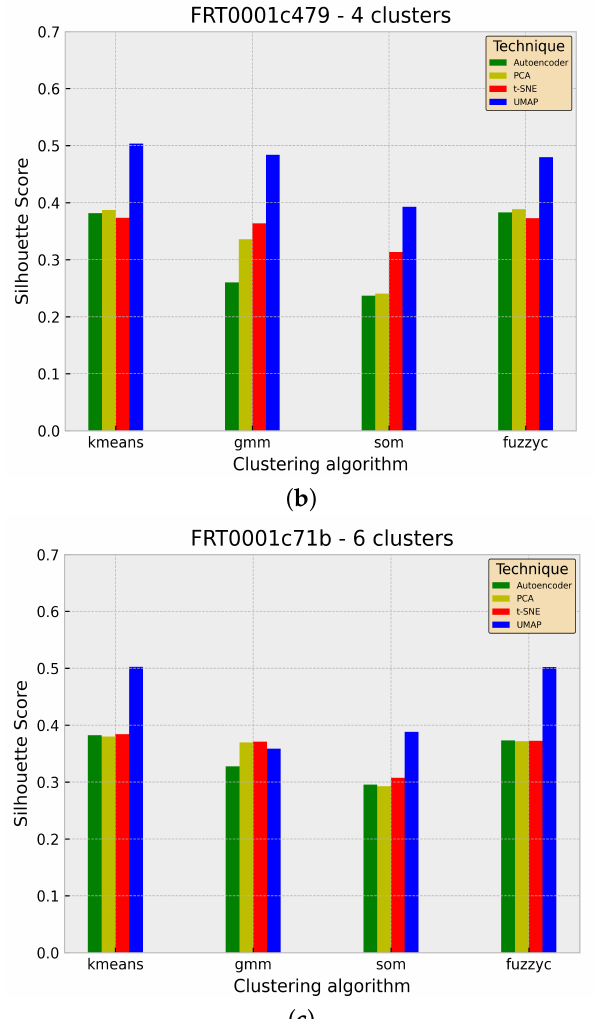
Figure 5. Silhouette coefficient for the identified number of clusters for each dataset across all examined methods. The scores are grouped by clustering algorithm. The UMAP algorithm has the highest SC score in all but one case. ( a ) FRT0000d3a4; ( b ) FRT0001c479; ( c )